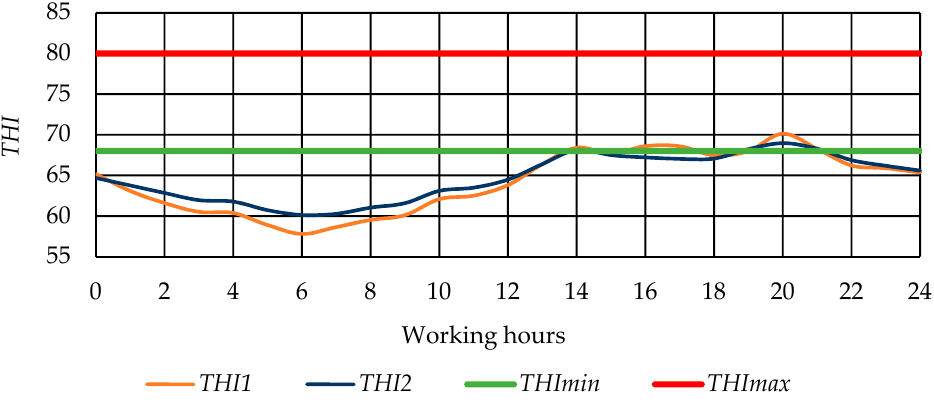
Figure 9. Dynamics of relative humidity on a moderate day (maximum temperature of 21.9 °C ).